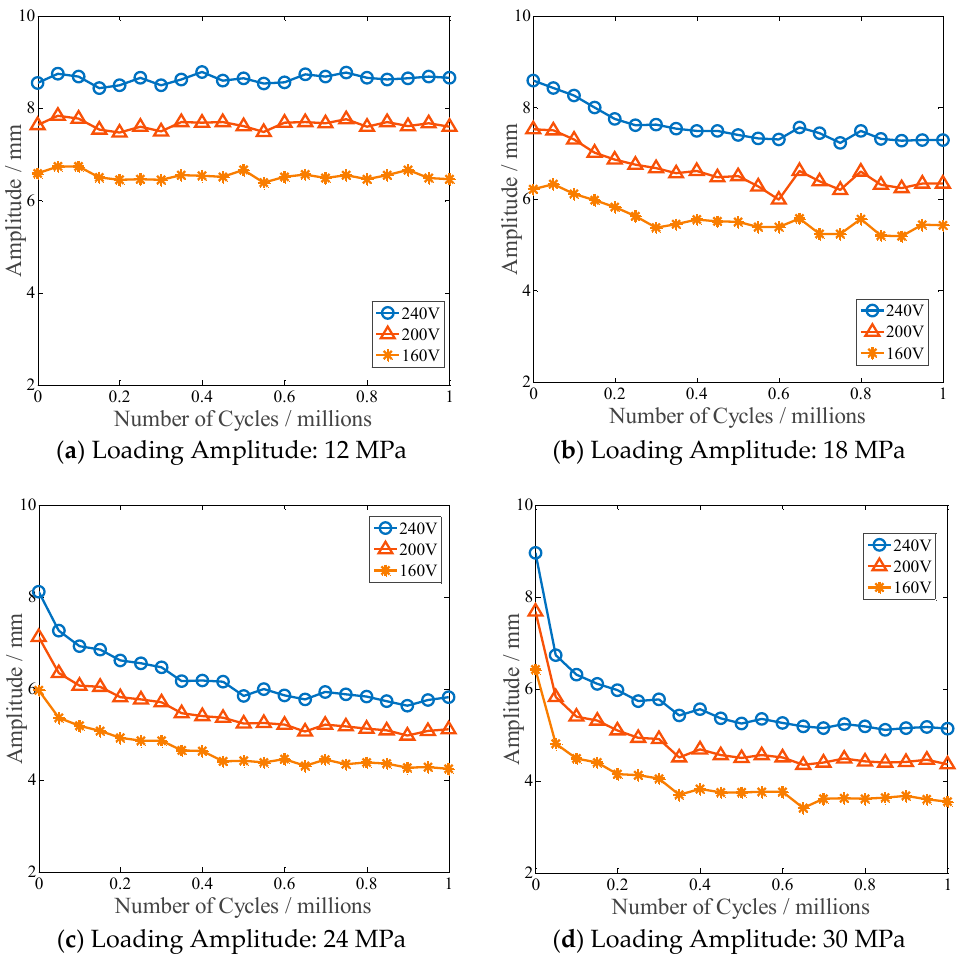
Figure 8. MFC actuated displacement amplitude of the four tested beams versus load cycles.